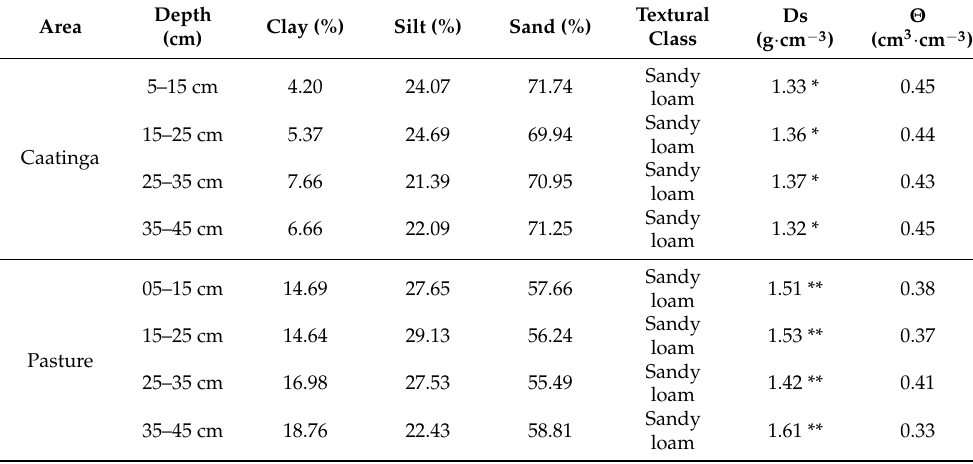
Table 1. Textural properties of the soil layers in the Caatinga (BR-CST) and Pasture (BR-GST) areas at depths between 5 and 45 cm.